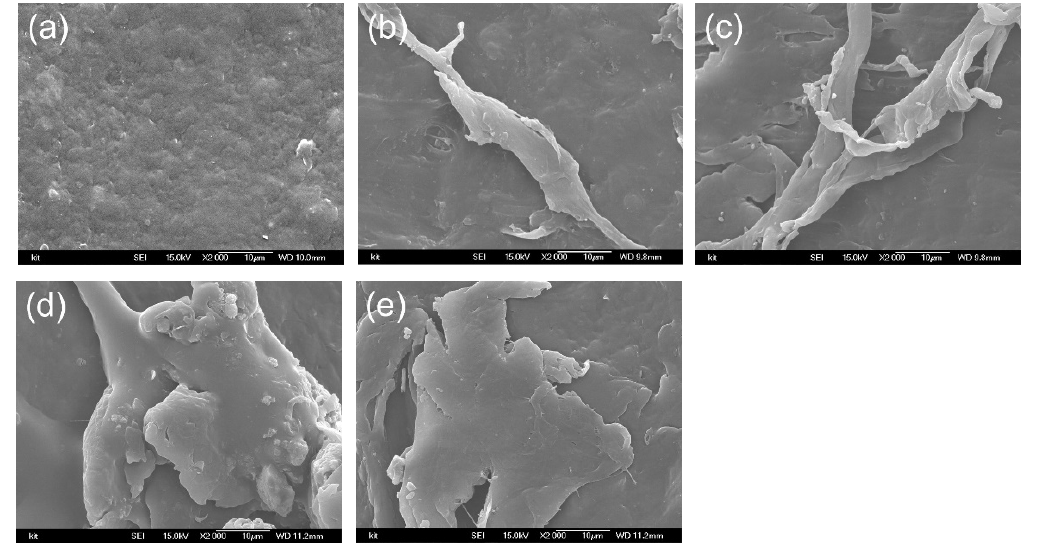
Figure 8. SEM images of polypropylene (PP) aggregate: ( a ) 0 kGy; ( b ) 25 kGy; ( c ) 50 kGy; ( d ) 75 kGy; ( e ) 100 kGy.